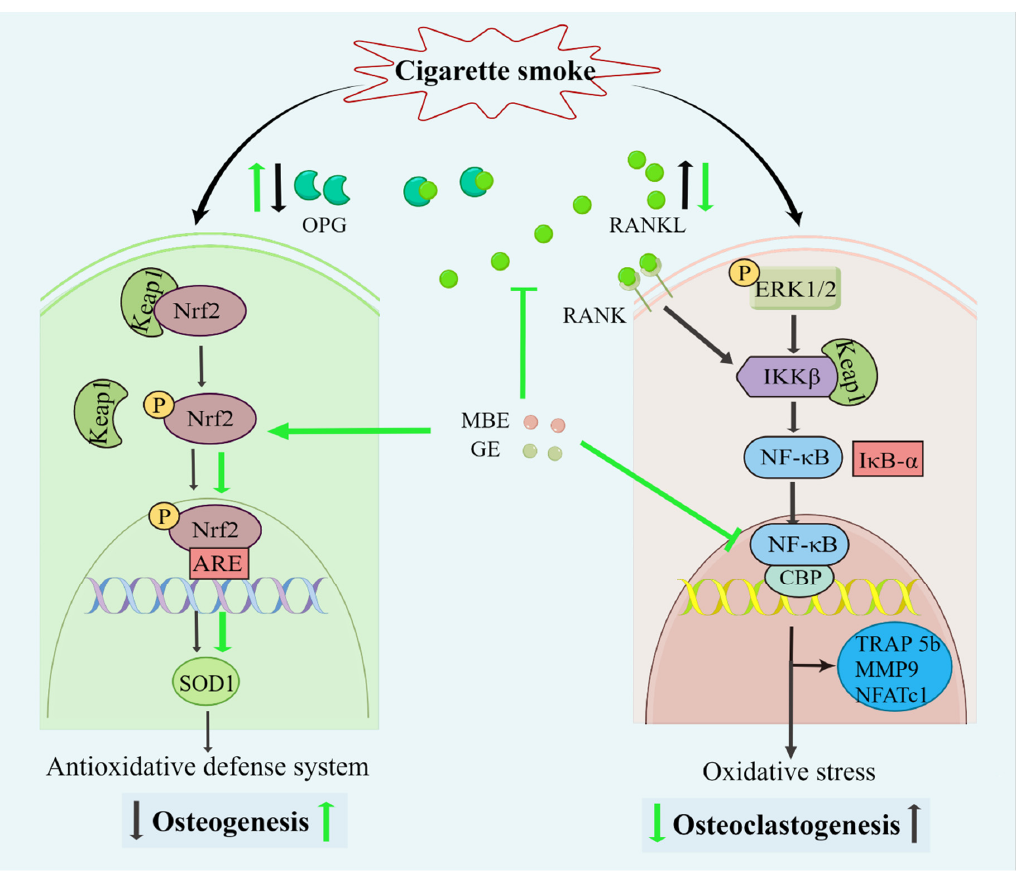
Figure 6. Diagram of the effects of MBE and GE on preventing CSE-induced bone cell damage. Both CSE and antioxidants could activate the Nrf2 signaling pathway. The dissociation of Keap1/Nrf 2 complexes prevents the degradation of transcription factor Nrf2 and, consequently, results in the activation of Nrf2. Combined with antioxidant response element (ARE) promoter, phosphorylated Nrf2 (p-Nrf2) triggers the antioxidative transcription of SOD1. Then, the antioxidative defense